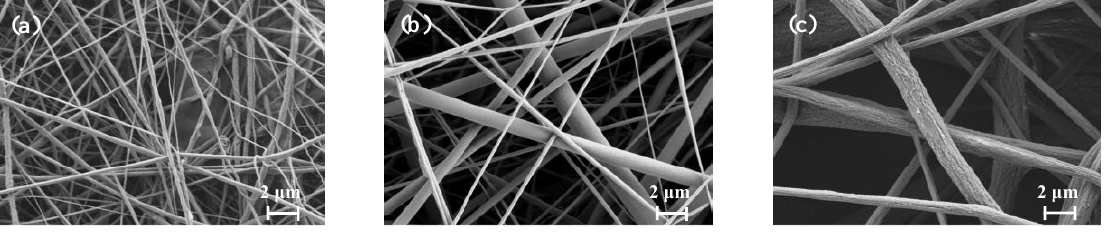
Figure 2. Typical SEM images of the nanofiber membranes obtained using PVDF mass fractions of ( a ) 14 wt.%, ( b ) 18 wt.%, and ( c ) 22 wt.%, denoted as ENM-14, ENM-18, and ENM-22, respectively.